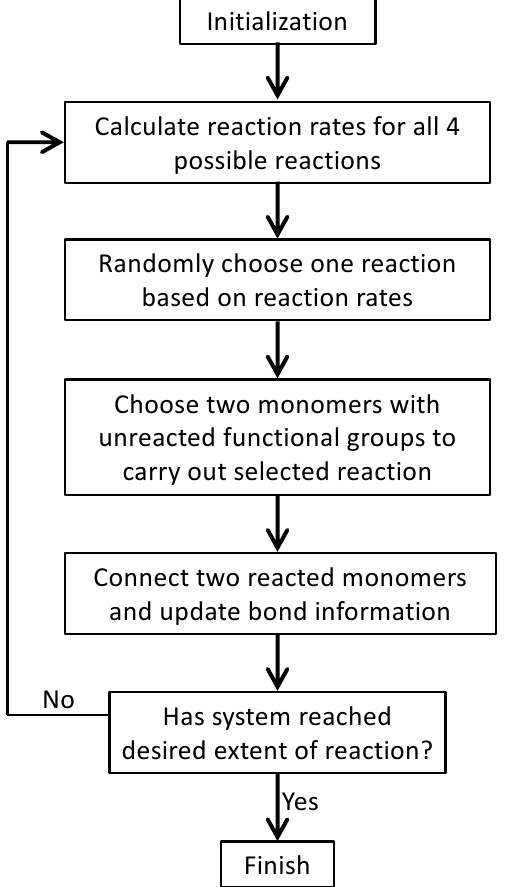
Figure 3. The flow chart of the MC simulation model of the branched PEI